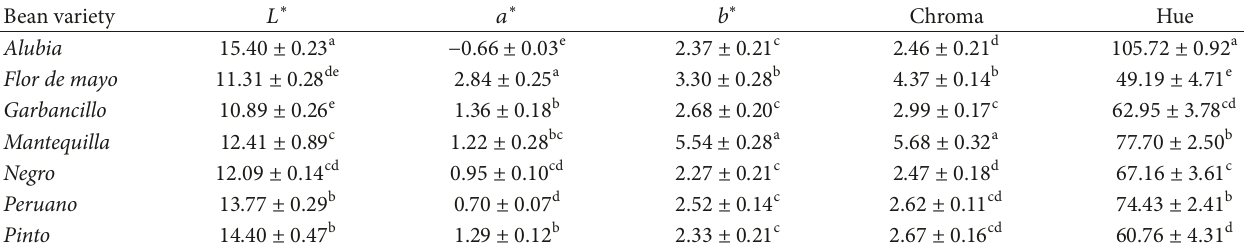
Table 3: Color values of the tested proteinaceous edible films obtained from the studied bean varieties a .